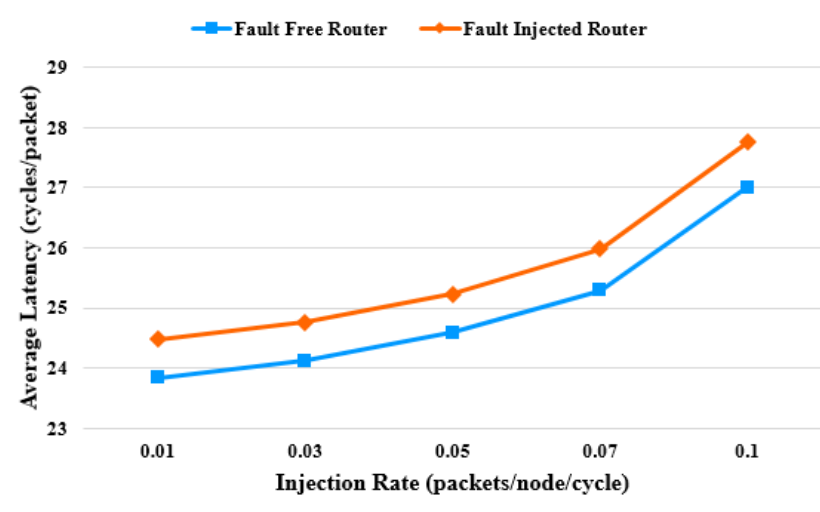
Figure 11. Latency comparison under uniform random traffic pattern.